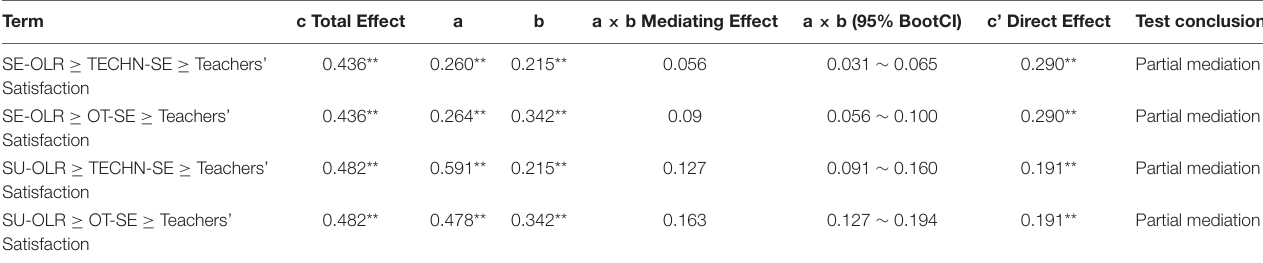
TABLE 8 | Mediation test